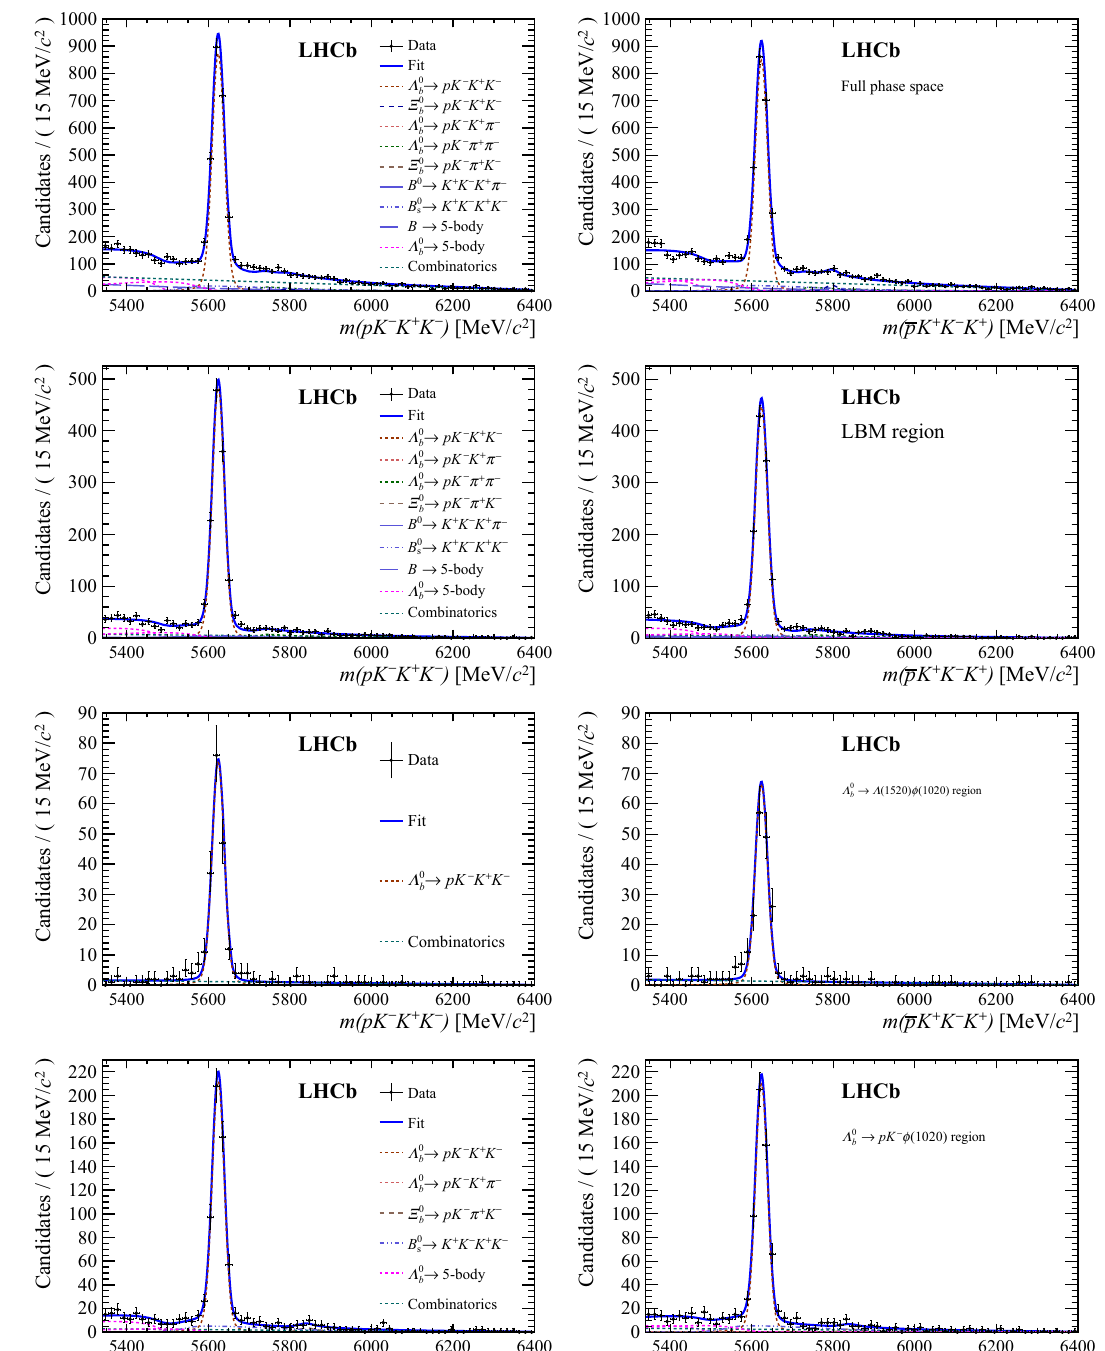
Fig. 6 Invariant pK − K + K − mass distributions, with the results of the fit superimposed: (first row) full phase space and (second row) → Λ( 1520 )φ( 1020 ) and (fourth row) Λ 0 LBM, (third row) Λ 0 b ( pK − ) φ( 1020 ) . The two columns correspond to the charge- high-mass conjugate final states: (left) baryon, (right) antibaryon. The differ-